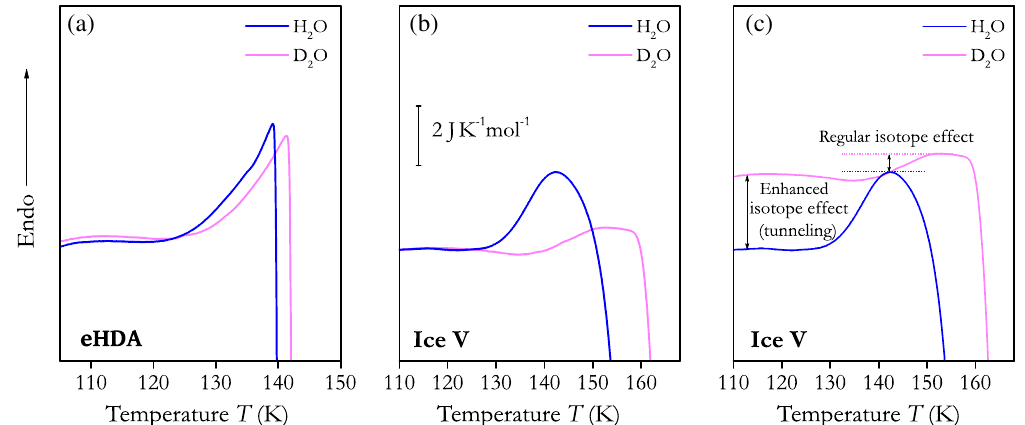
FIG. 9. Isotope effect on the heat flow at the glass transition of (a) eHDA measured at 50 K min − 1 and (b) ice Vat 30 K min − 1 . Panel (c) suggests that the larger isotope effect for ice V is caused by strongly enhanced H-quantum tunneling below T prepared following the protocol described by Salzmann et al. [28]. The signal is normalized to 1 mol, and the scans are moved vertically for